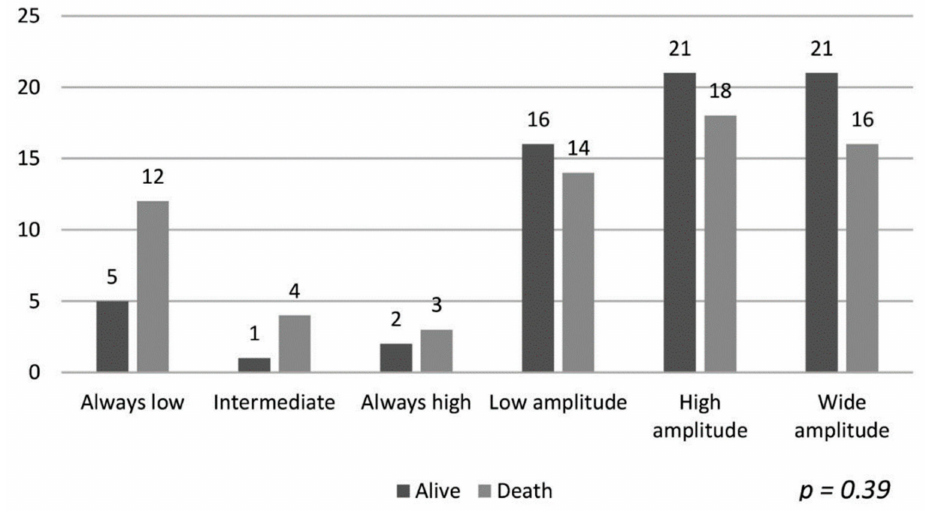
Figure 2. Patterns of variability in hemoglobin levels (according to Ebben et al. [4]) and mortality. Table 4. Factors associated with mortality in the long term (78 months): univariate Cox regression model.